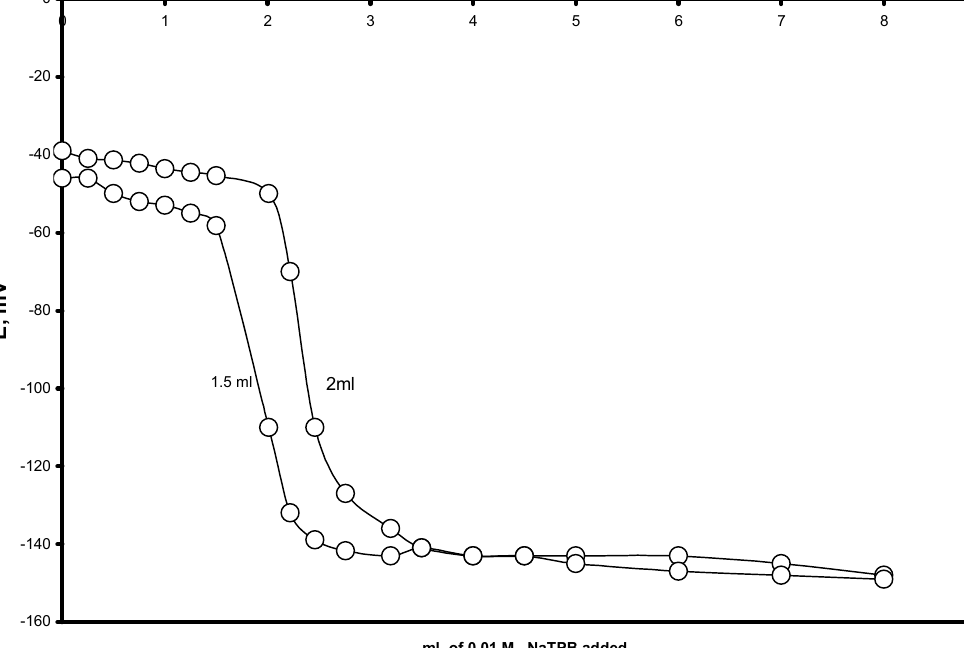
Figure 3.a. Typical potentiometric titration curves of 1.5 and 2 ml of 1 × 10 -2 M AC with 1 × 10 -2 M sodium tetraphenylborate using AC-TPB membrane sensor.